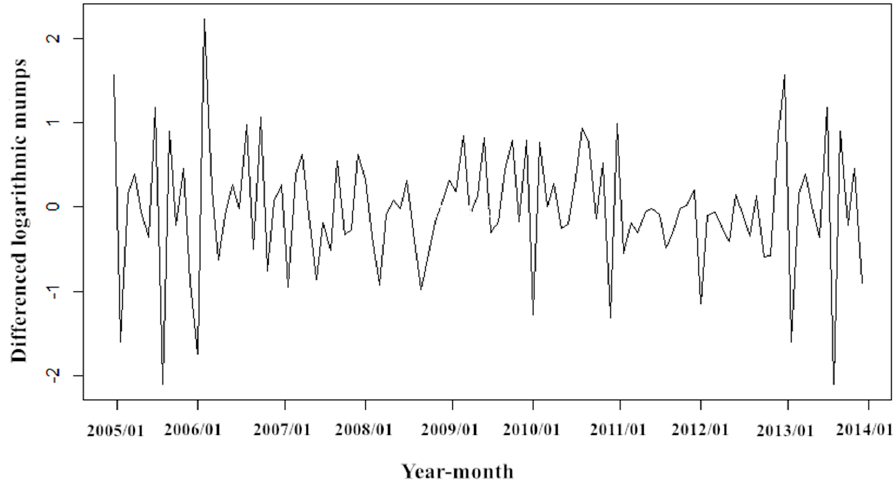
Figure 5. Monthly mumps cases after the logarithmic transformation and difference in Zibo City.